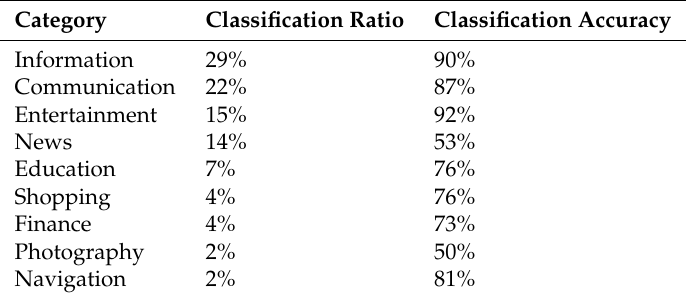
Table 3. Top app types by use frequency.